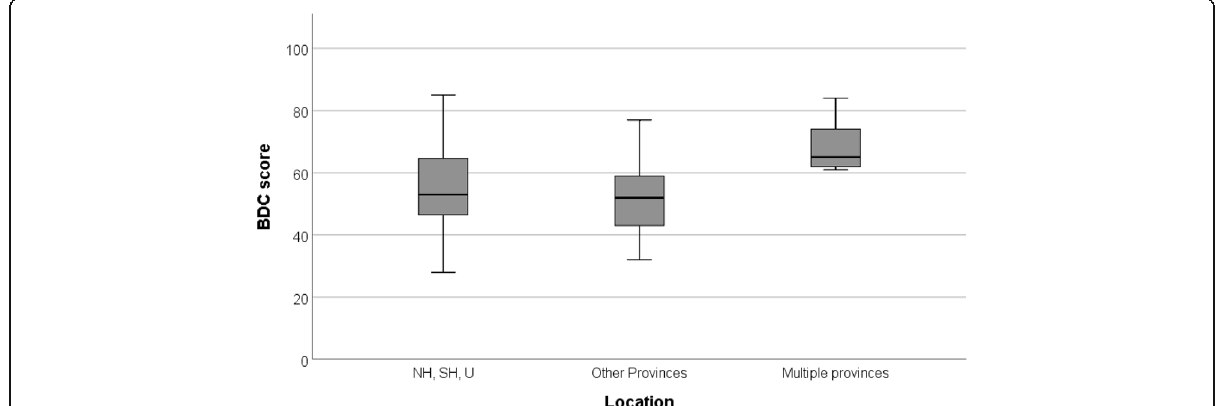
Fig. 3 Box-and-whisker diagram illustrating the distribution of BDC scores of the websites as classified by practice location. NH, SH, U stand for the provinces of North Holland, South Holland and